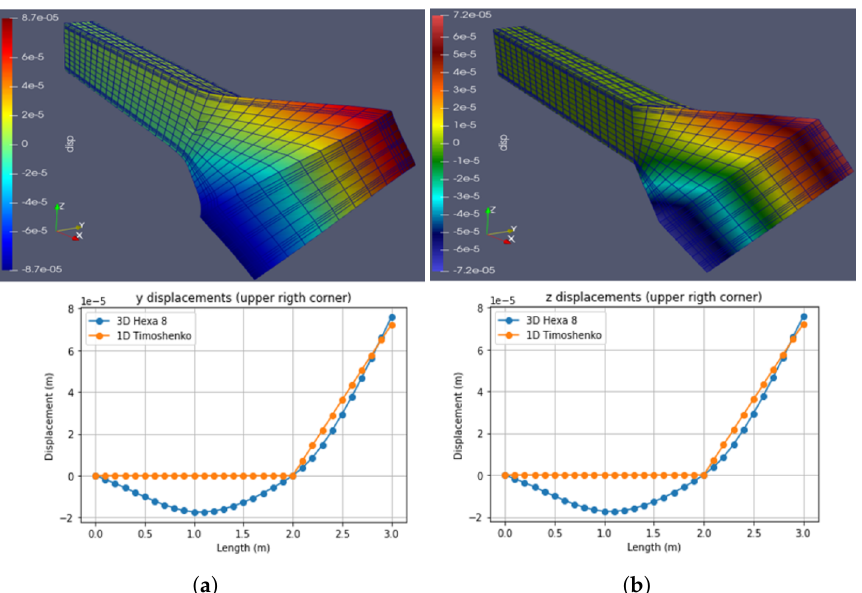
Figure 17. Case 4: Torsional load at L = 3 m (2800 N.m). ( a ) Hexa8. ( b ) Timoshenko. (Note: e − n indicates 10 − n ).